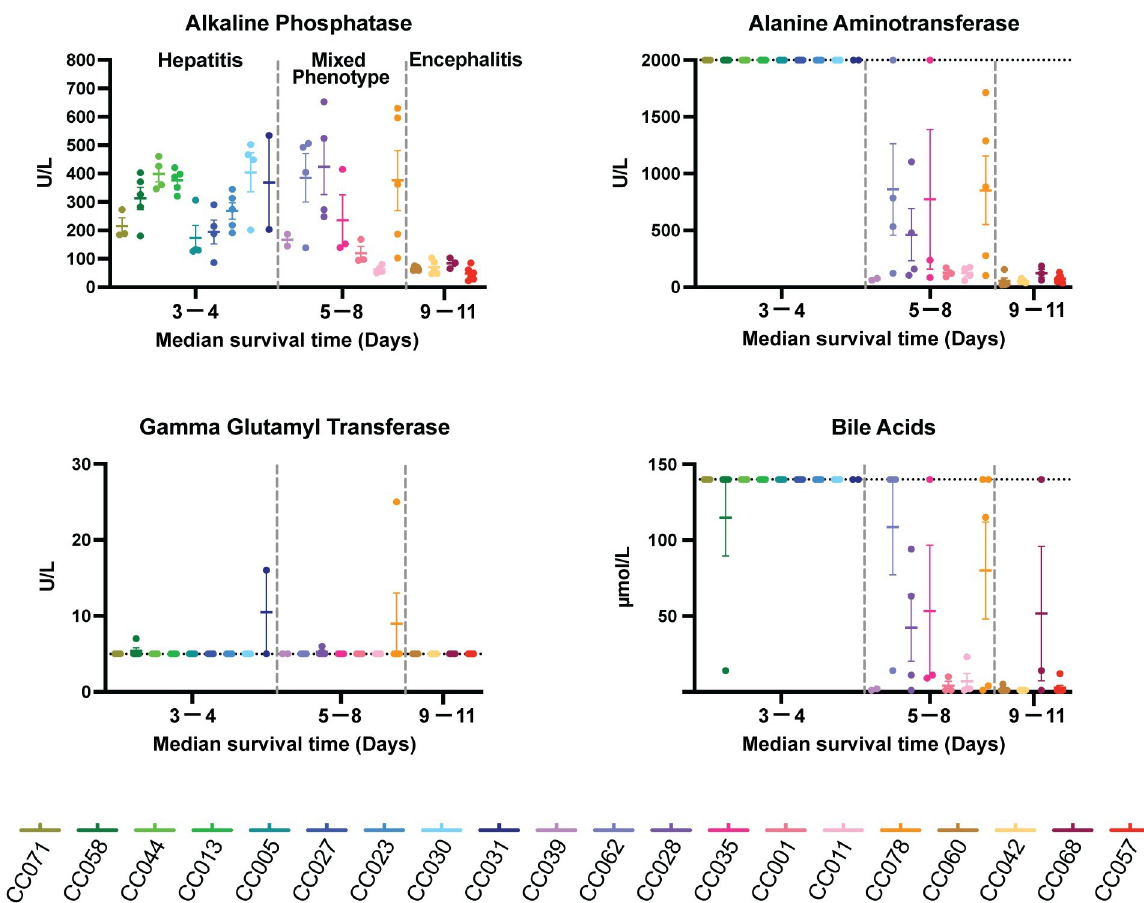
Fig 2. Liver chemistry profiles vary across CC strains and correlate with RVF disease. CC strains are separated into three categories of disease by two vertical dashed grey lines. CHEM was run if sufficient sample was present (n � 5 per CC strain). Data shown as mean ± SD. If data were outside the LOD, the upper or lower LOD for assays are noted by horizontal dotted lines. Alanine Aminotransferase upper LOD: 2000 U/L; Gamma Glutamyl Transferase lower LOD: 5 U/L; Bile Acids upper LOD: 140 μ